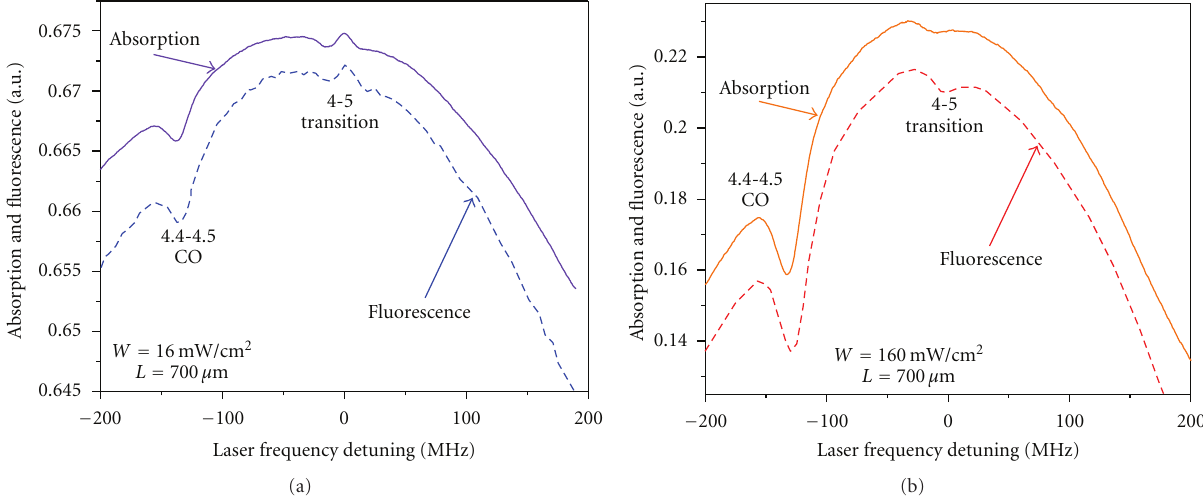
Figure 11: Sign reversal of the velocity selective optical pumping resonance with light intensity, observed at the F g = 4 → F e = 5 transition in L = 700 μ m cell. Cell temperatures T = 25 ◦ C. Laser light intensity: W = 16mW/cm 2 (a) and W = 160 mW/cm 2 (b). CO denotes the cross-over resonance for both light intensities. Table 1: Calculated values for 133 Cs: vapor pressure P , atomic density ρ , most probable Cs atomic velocity ν , collision rate r coll , mean free path between the collision of two Cs atoms λ , time between two atomic collisions τ int with the cell wall (having d : the thin-cell window diameter), time between two atom collisions τ coll , and the number of collisions n collCs Cs-Cs during a complete flight along the cell diameter d . T 1 = 120 ◦ C = 393 K T 2 = 34 ◦ C = 307 K 0.254695